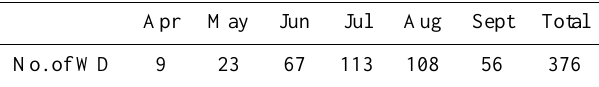
Table 3. Number of WD per month in Castile and Leon between 1987 and